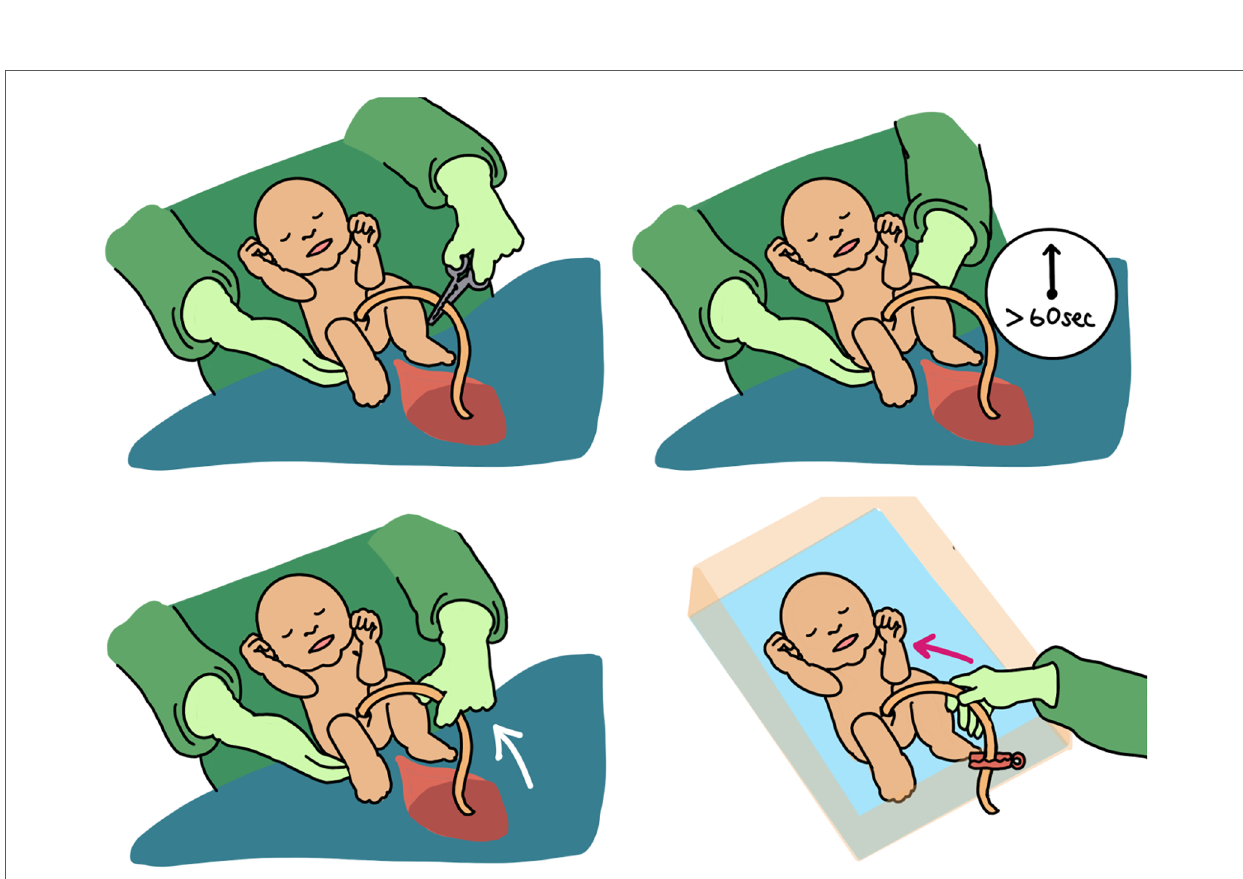
FIGURE 1 Early cord clamping (ECC) vs delayed cord clamping (DCC) vs. intact cord umbilical cord milking (I-UCM) vs. cut-cord umbilical cord milking (C-UCM). Different methods of cord management are depicted